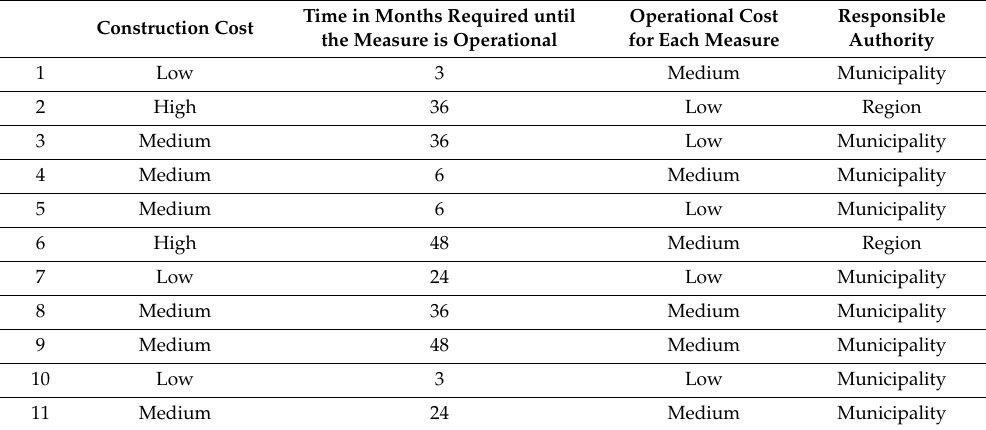
Table 4. Parameters defined related to flood strategies under